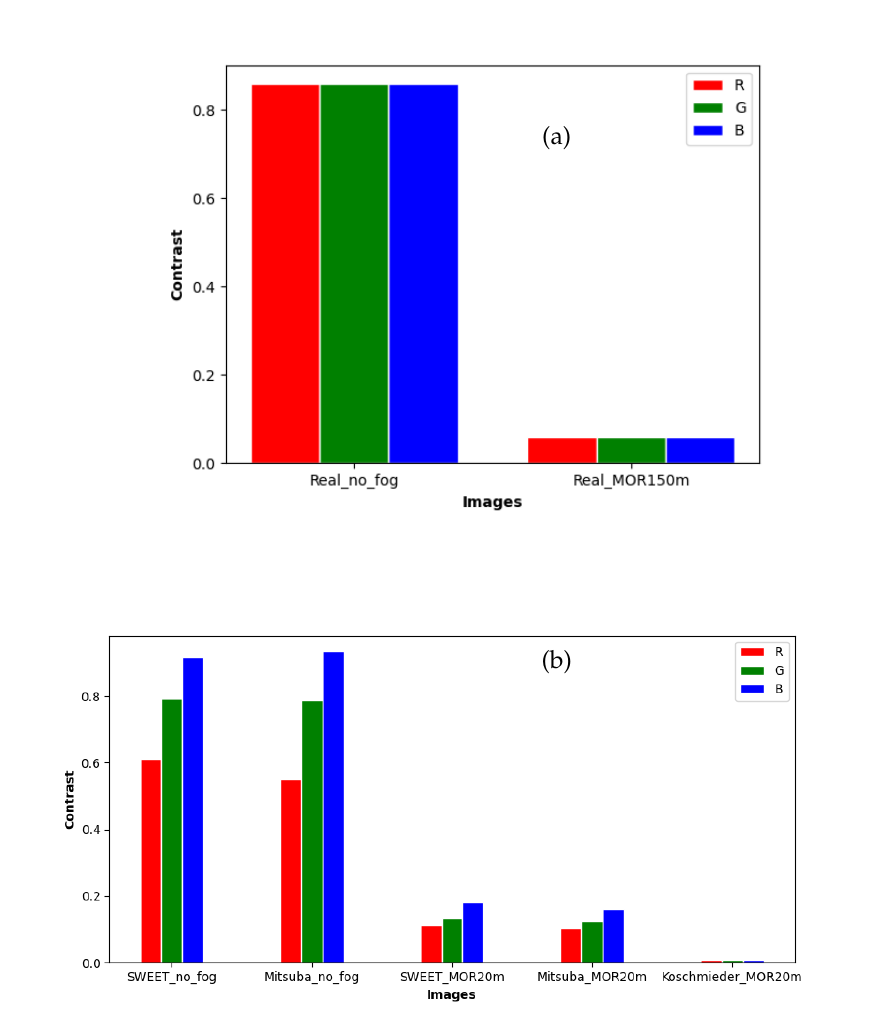
Figure 14. Comparing the contrast of objects for images from real images ( a ) to that of simulated images (SWEET, Mitsuba and Koschmieder) ( b ).